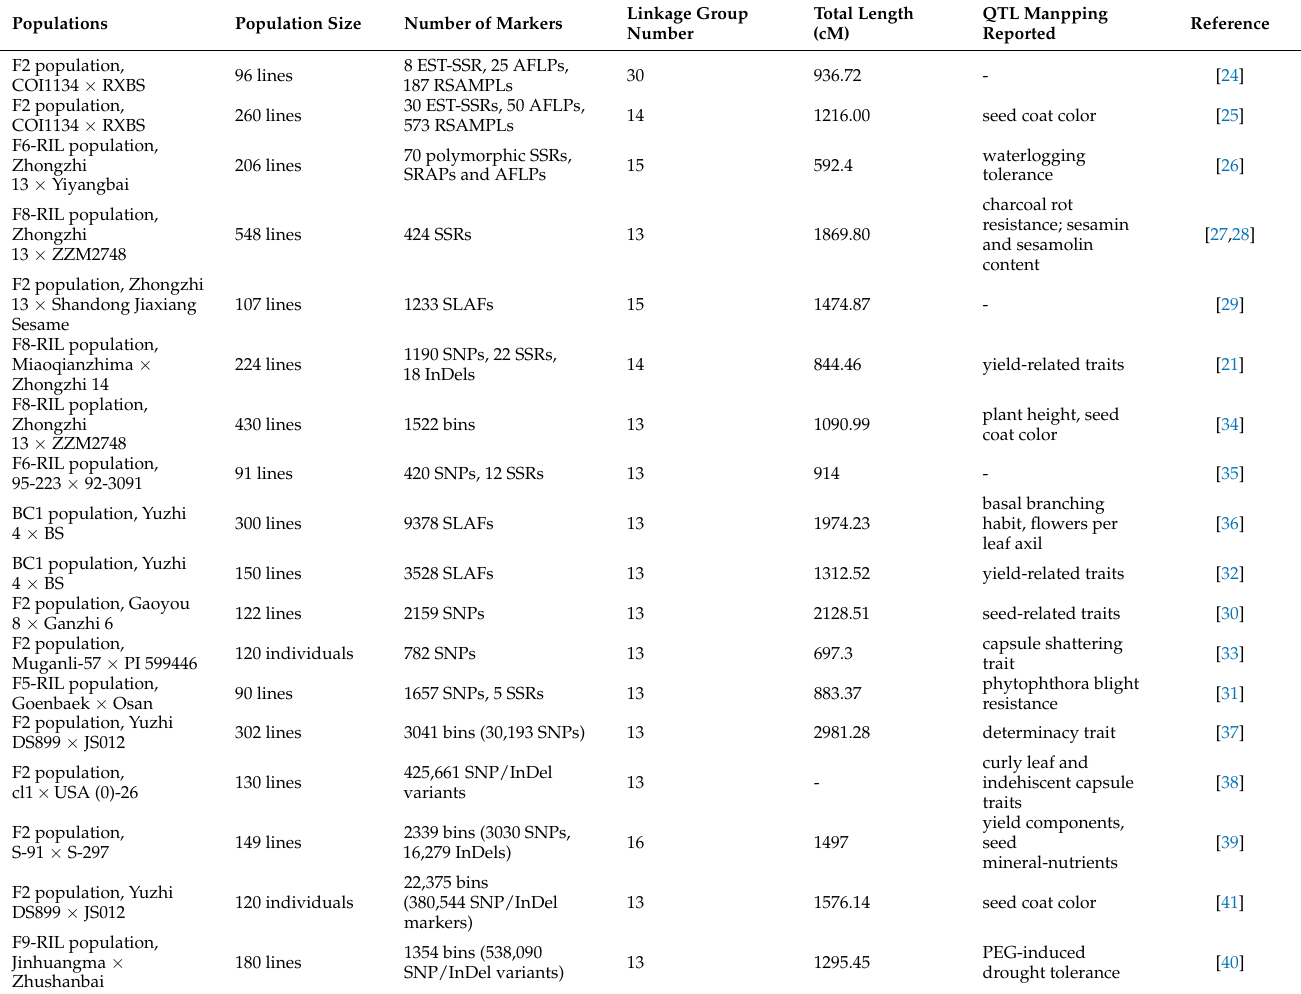
Table 3. The status of genetic linkage map in